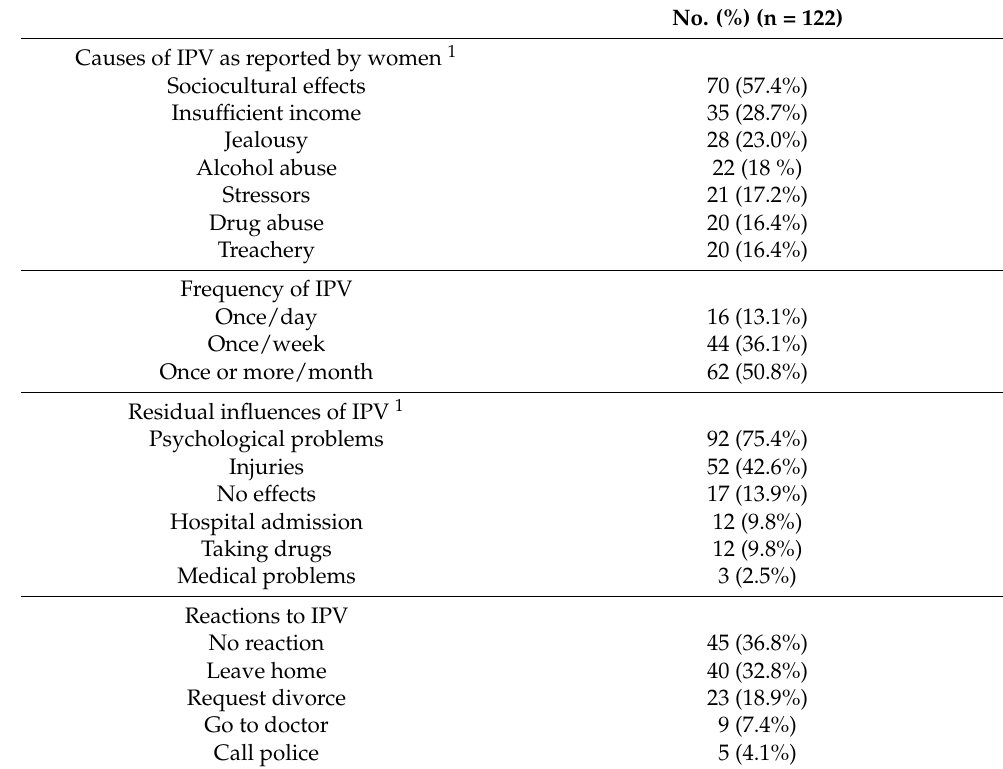
Table 5. Reasons, consequences, and reactions to IPV among women attending different primary health centers in the Aljouf region, Saudi